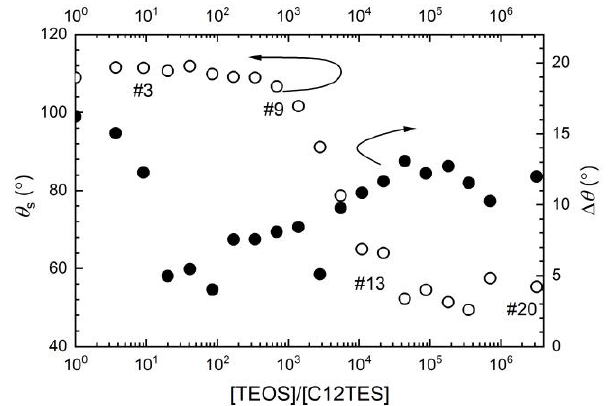
Figure 2. Changes in the static water CAs ( θ s , open circle) and CA hysteresis ( ∆ θ , filled circle) of the hybrid films as a function of the [TEOS]/[C12TES] molar ratios. [TEOS]/[C12TES] ratios = 9.1 (#3), 690 (#9), 11,000 (#13), 1,400,000 (#20).